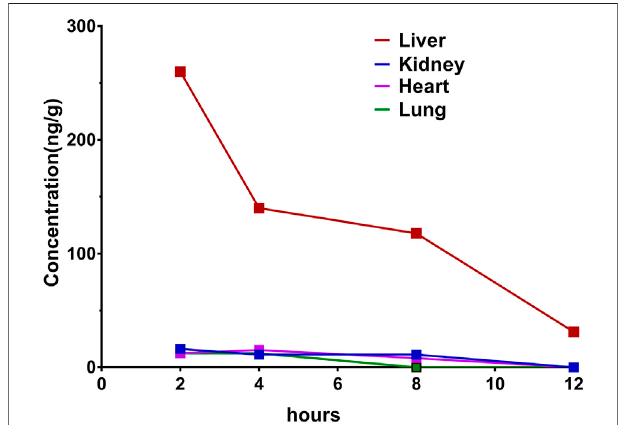
FIGURE 6 | Effects of continuous administration of Indo5 for 21 days on liver injury in mice. The mice were orally administered with Indo5 (60 mg/kg, once daily) for 21 days ( n (cid:2) 6). Serum levels of ALT (A) and AST (B) were measured at the indicated time points. At the indicated time, the mice were killed for histopathological examination of liver tissue (C) . Data are presented as the mean ± SD. Two-tailed t tests were performed. * p < 0.05 were regarded as statistically signi fi cant, compared with control